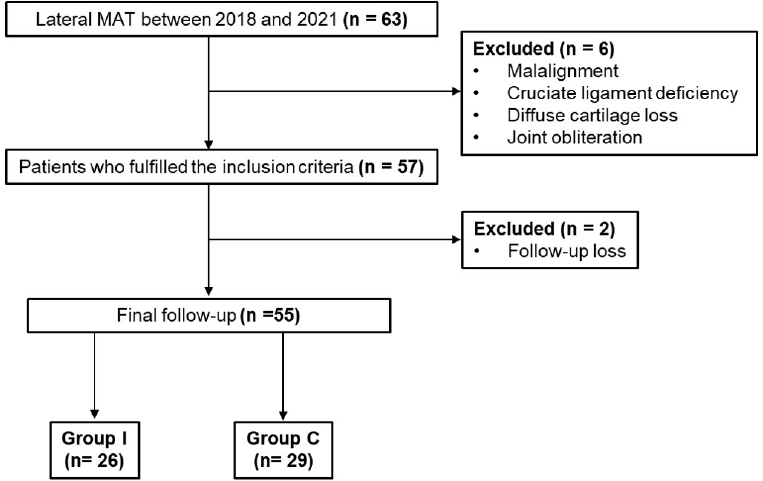
Figure 1. Flowchart of included patients in both